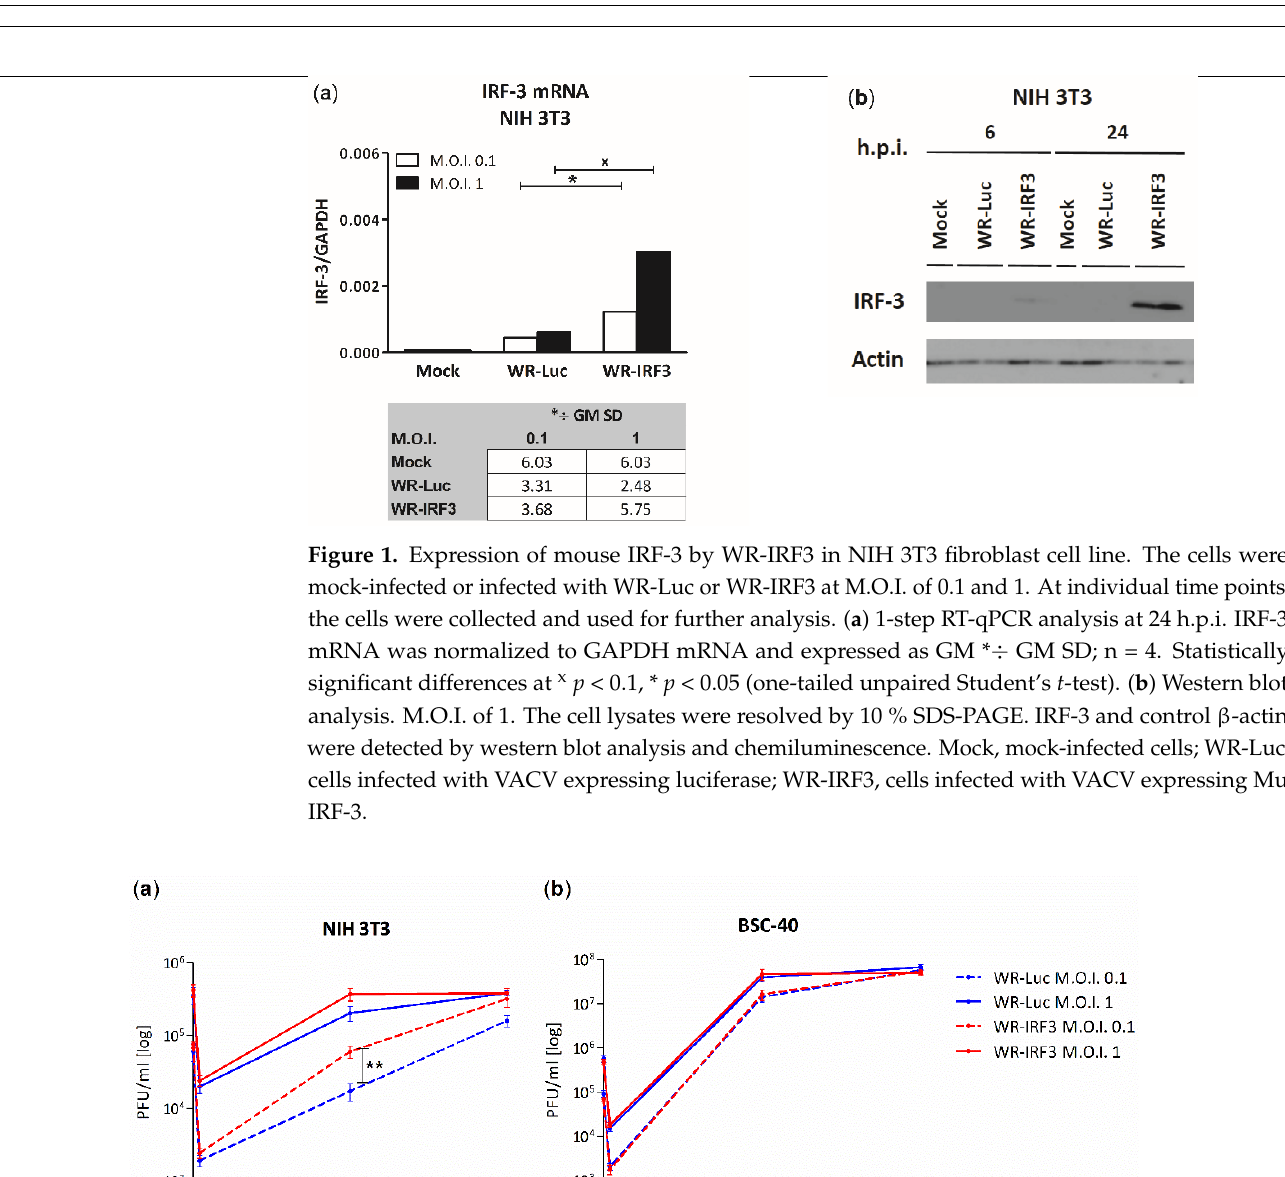
Figure 2. IRF-3 expressed by WR-IRF3 increases VACV growth in mouse cells. ( a ) NIH 3T3 and ( b ) BSC-40 cells were infected with WR-Luc or WR-IRF3 at M.O.I. of 0.1 and 1. At individual time points, the cells were collected and used for determination of virus titer. Graphs represent means of 3 independent experiments performed in duplicates +/ − SEM. ** p < 0.01 (two-tailed unpaired Student’s t -test). WR-Luc, cells infected with VACV expressing luciferase; WR-IRF3, cells infected with VACV expressing Mu IRF-3.